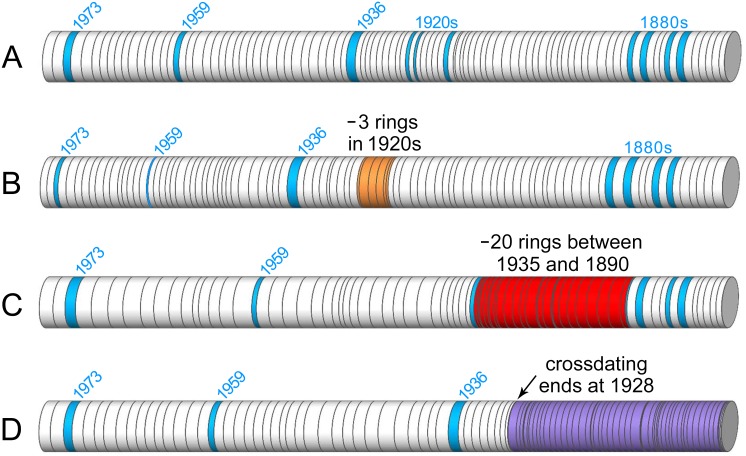
Classification system for crossdating confidence based on annual resolution.Marker years are denoted in blue. Examples are drawn from Sequoia sempervirens ring-width data. (A) High crossdating confidence or continuous annual resolution with no or few missing rings. (B) Moderate crossdating confidence (orange). Although missing rings are placed in their most likely location, alternative positions are possible (e.g., 3 missing rings between 1918–1926). Also assigned to sections of miniscule growth (e.g., missing rings among micro-rings). (C) Bounded with no annual resolution (red). Total number of missing rings in a section deduced from surrounding crossdating, but there is no indication of their most likely placement, often due to many missing rings (e.g., 20 missing rings between 1890–1935). (D) Crossdating cessation (purple). No annual resolution for a section where crossdating terminated and interior rings are neither resolved nor bound by known markers (e.g., crossdating progressed towards pith and ceased at 1928, leaving an undated section of core with a minimum ring count).